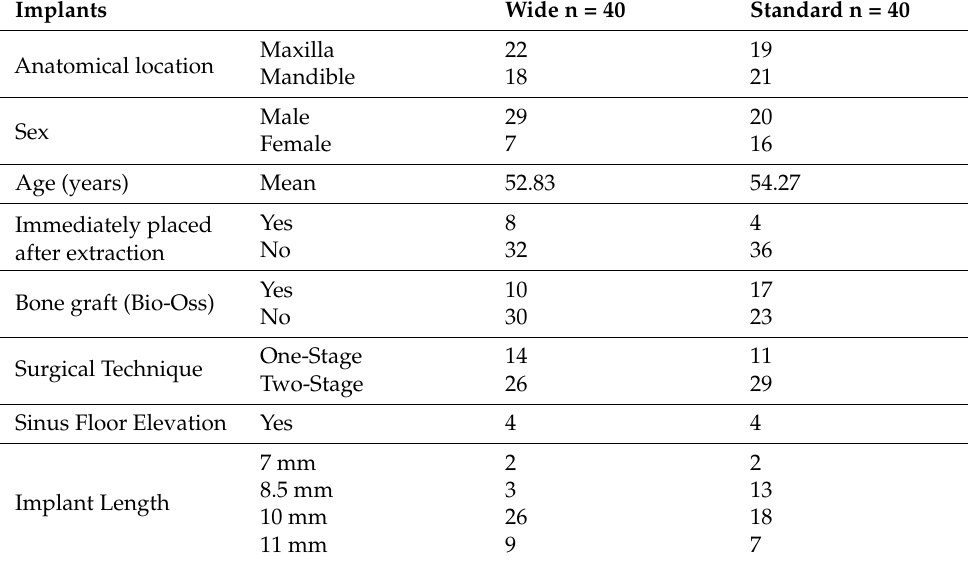
Table 1. Patient demographic data.